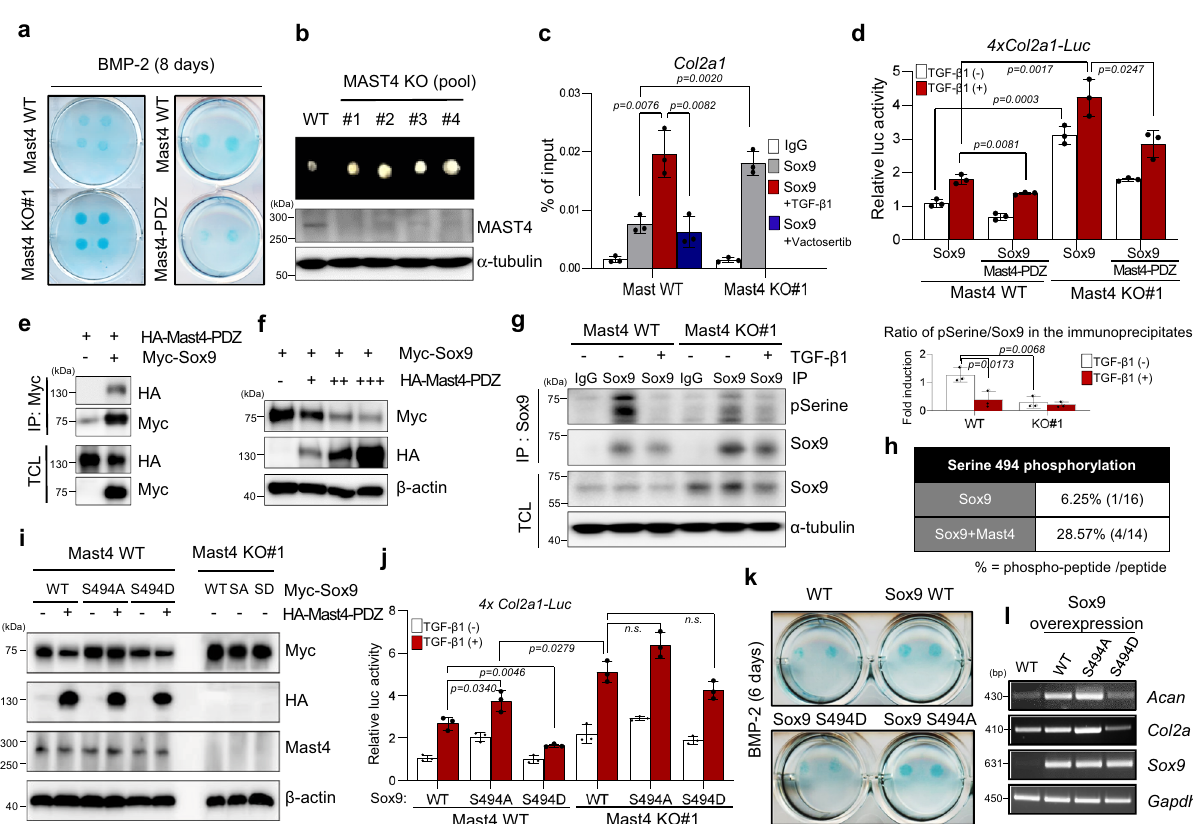
Fig. 2 Mast4 modulates chondrogenesis through post-translational regulation of Sox9. a Alcian blue staining results of C3H10T1/2 cells. b 2×10 5 of hBMSC were differentiated into chondrocytes for 21 days, followed by protein extraction from the pellets. c C3H10T1/2 cells were differentiated into chondrocytes for 6 days, followed by Sox9 ChIP on Col2a1 gene (TGF- β 1 (5 ng/ml) and Vactosertib (0.5 μ M), a TGF- β type I receptor kinase inhibitor, for 48 h). d 4xCol2a1-luc, Sox9, and Mast4-PDZ were transiently overexpressed in the wild-type and Mast4-depelted C3H10T1/2 cells, followed by TGF- β 1 treatment (3 ng/ml for 24 h). e Mast4-PDZ and Sox9 were transfected to C3H10T1/2 cells, followed by immunoprecipitation assay. f Western blot analysis of Sox9 stability in C3H10T1/2 cells. g Wild-type and Mast4-depleted C3H10T1/2 cells were differentiated to chondrocytes for 6 days, followed by TGF- β 1 (5 ng/ml for 48 h) and MG-132 (10 μ M for 6 h) treatment, and Sox9 immunoprecipitation. Band intensities representing pSerine and Sox9 were converted by densitometry using ImageJ. Data are reported as mean ± SD of three independent experiments ( n = 3). Unpaired two-tailed Student ’ s t test ( P < 0.05) was conducted for statistical analysis. h Sox9 and Mast4-PDZ were transfected to C3H10T1/2 cells in the presence of MG-132 (10 μ M for 6 h). Two independent MASS SPEC analyses were conducted. i Mast4-PDZ was co-transfected with Sox9 wild-type (WT), S494A, or S494D mutants into C3H10T1/2 cells. j 4xCol2a1-luc and Sox9 WT/S494A/S494D were co-transfected to C3H10T1/2 cells, followed by TGF- β 1 treatment (3 ng/ml for 24 h). k Representative alcian blue staining of C3H10T1/2 cells stably overexpressing Sox9 WT, S494A, and S494D in micromass cultures for 6 days. l The wild- type and stably overexpressing Sox9 WT, S494A, and S494D C3H10T1/2 cells were differentiated into chondrocytes for 6 days. The mRNA